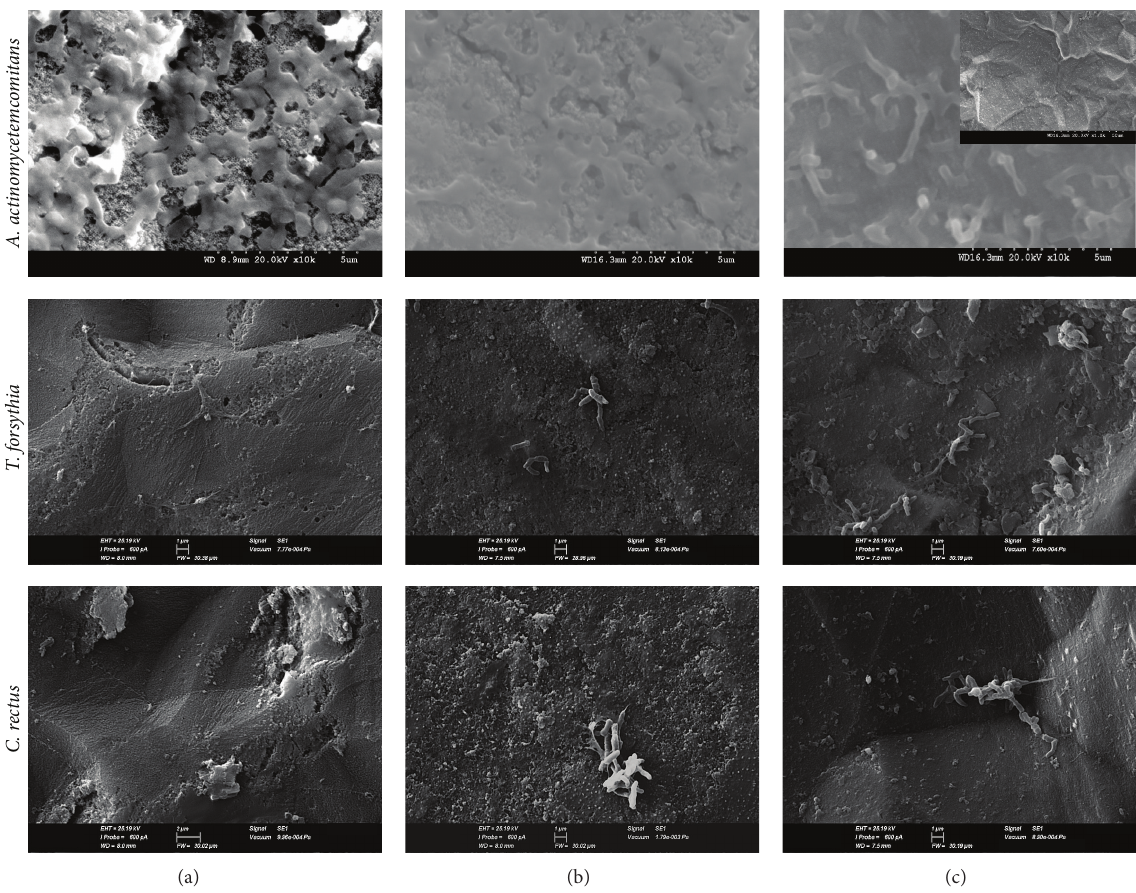
Figure 4: SEM micrographs after adhesion of A. actinomycetemcomitans , T. forsythia , and C. rectus on the surface of (a) Group TiO 2 : as- annealed TiO 2 nanotubes; (b) Group Ag: as-annealed Ag doped TiO 2 nanotubes; (c) Group Ti: commercially pure Ti